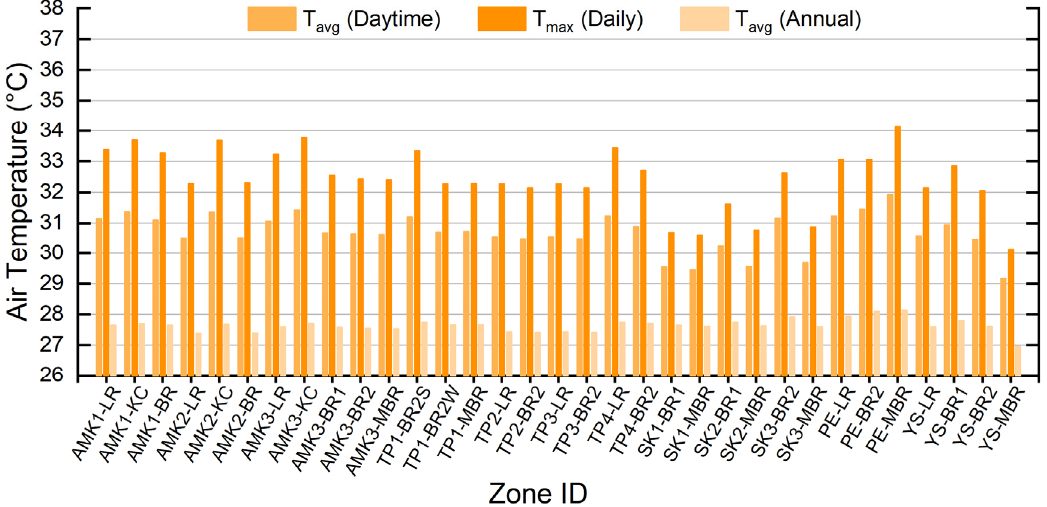
Figure 11. Average and maximum T a in target zones for window open scenario.